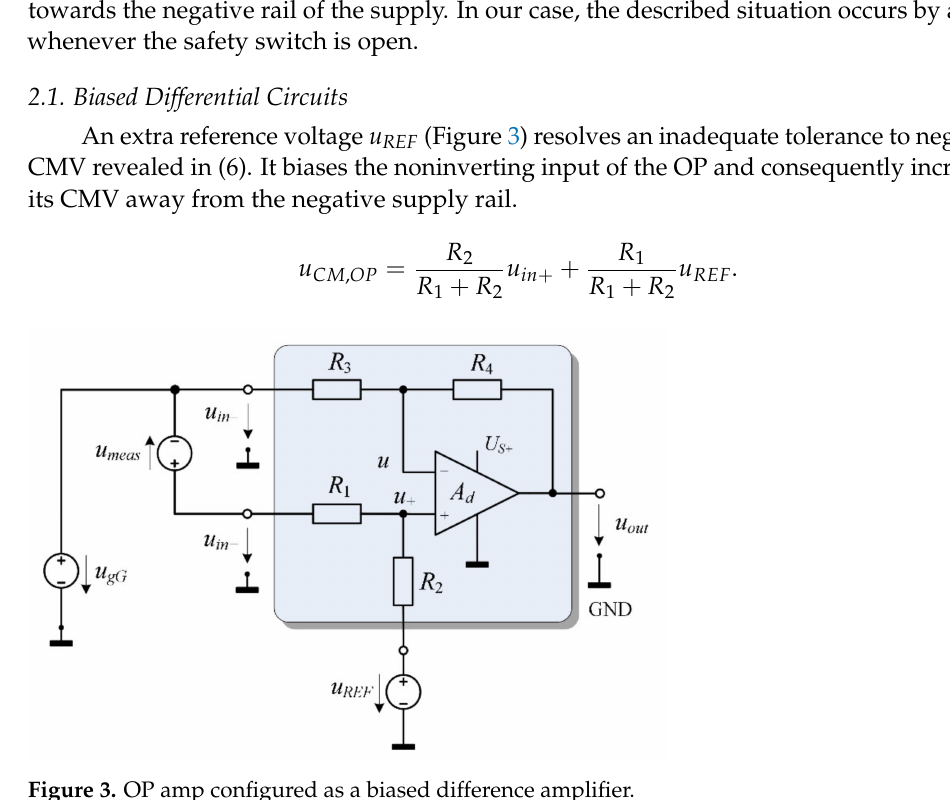
Figure 3. OP amp configured as a biased difference